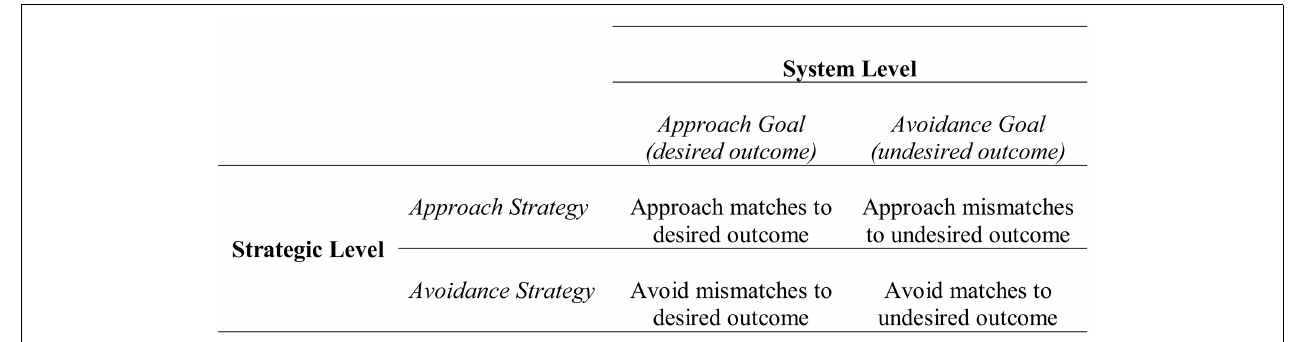
FIGURE 1 | Relationship between the system and strategic levels of the hierarchical model of motivation . Figure adapted from Higgins et al. (1994).